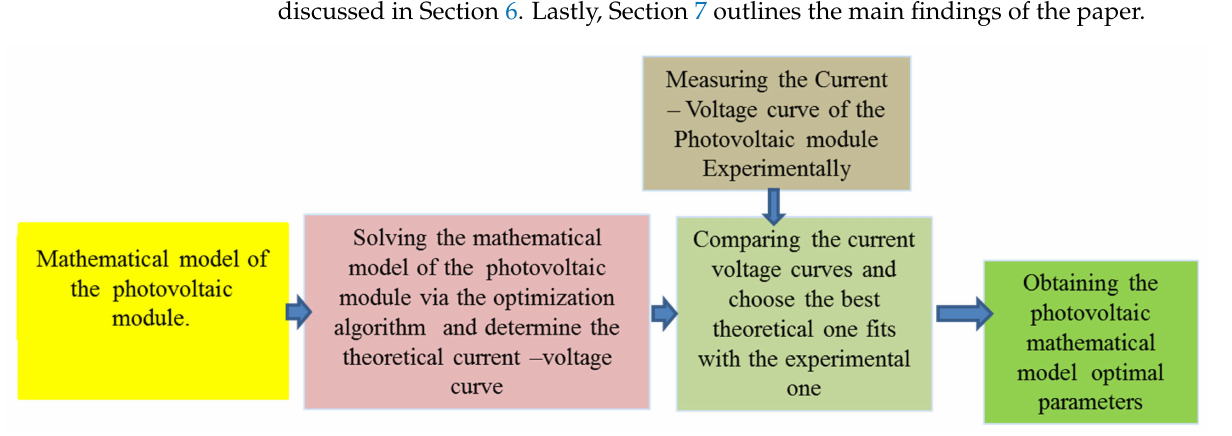
Figure 2. The flow chart of the planned research.